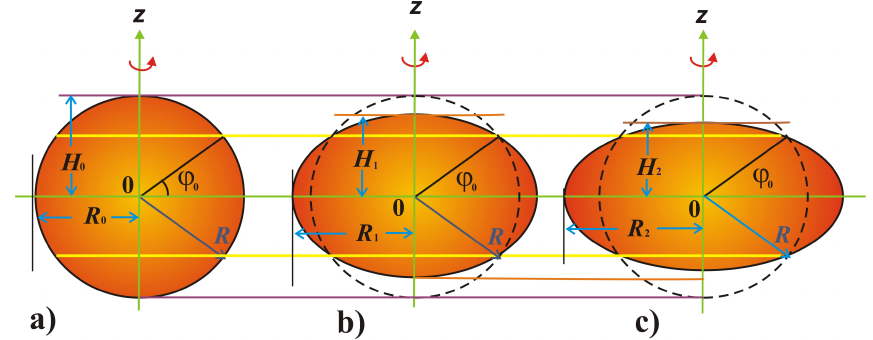
Fig. 4. The sketch of the rotating celestial body: three fragments for three different values of angular velocity. The angular velocity value ω 0 ≈ 0 (a) ; the angular velocity is ω 1 >ω 0 (b) ; the angular velocity is ω 2 >ω 1 >ω 0 (c) . The yellow solid line denotes critical latitude for three fragments of the rotating body. The dotted black circles on the (b) and (c) fragments indicate the spheres whose volume is equal to the volumes of rotating ellipsoids.